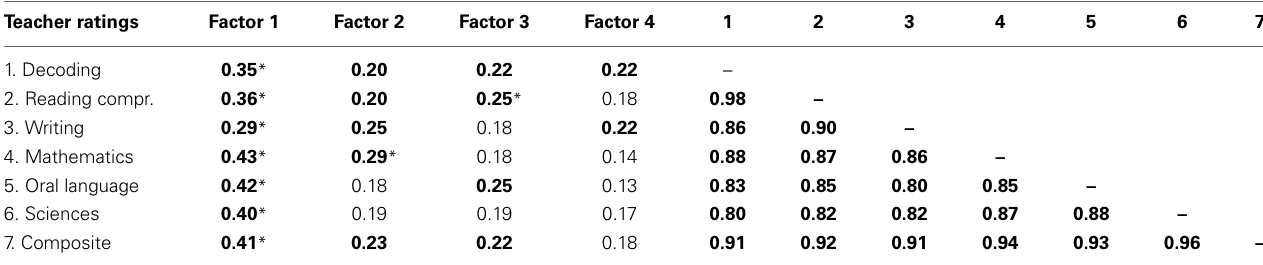
Table 6 | Partial correlations (controlling for age in months) between the identified executive function factor structure and teacher ratings using Pearson’s correlation coefficients ( N =